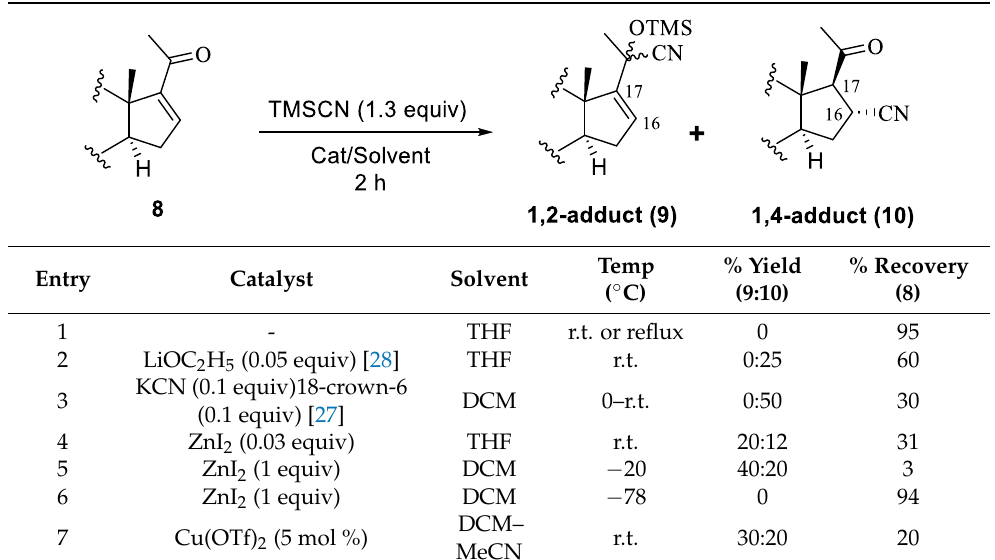
Table 1. Addition of TMSCN to α , β -enone 8 .